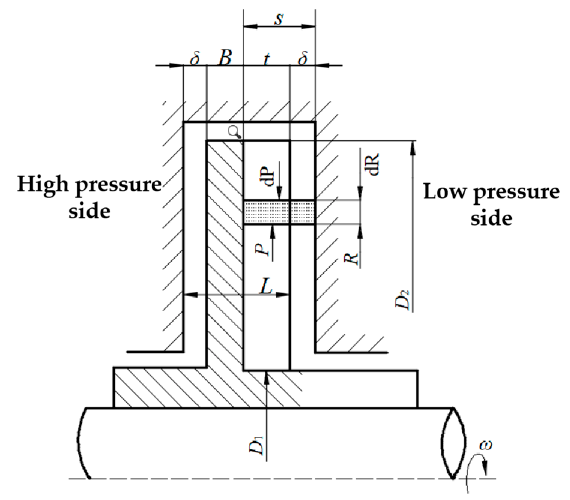
Figure 15. Calculation of the seal pressurization value.